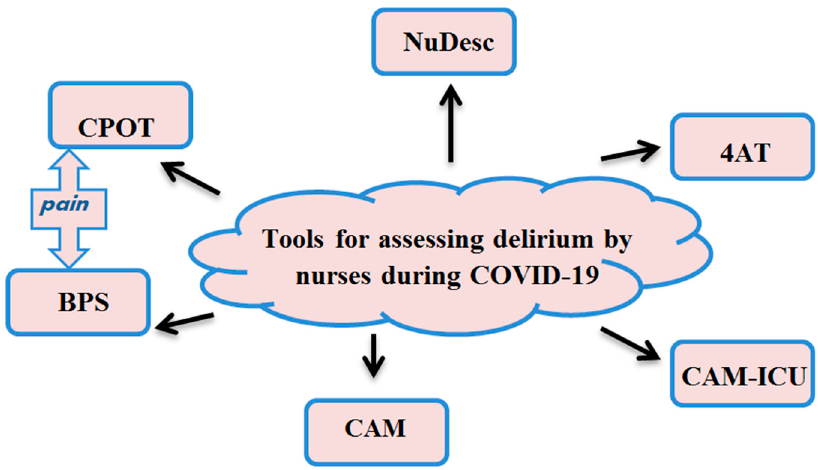
Figure 2. Scales, presented in the literature, recommended for use by nurses of patients with delirium [19].